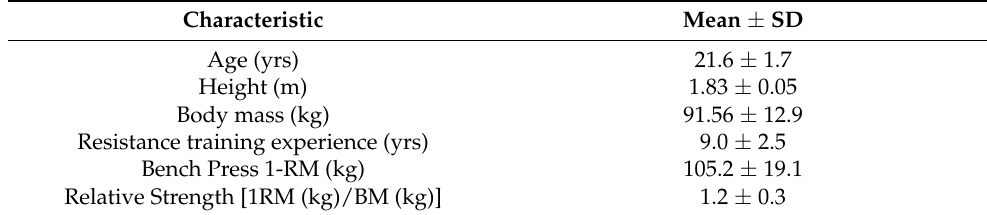
Table 1. Descriptive Characteristics ( n =